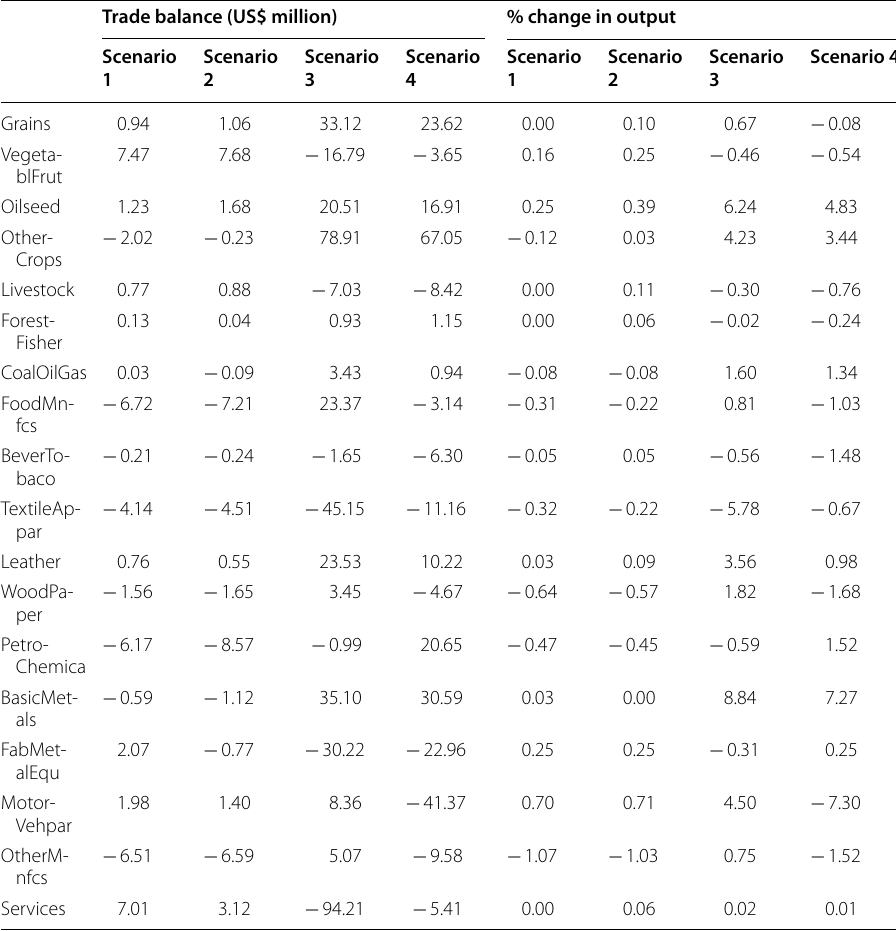
Table 14 Changes in Trade balance and output for Ethiopia. Source: Model